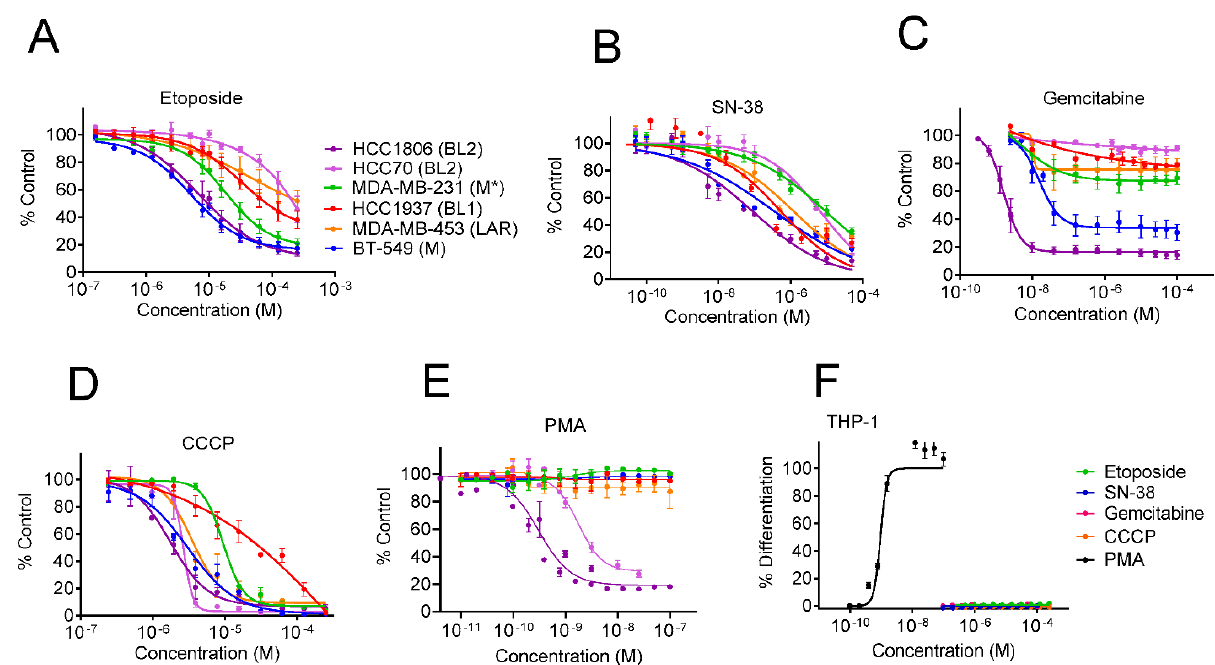
Figure 3. TNBC selectivity and THP-1 differentiation profiles of compounds with mechanisms associated with yuanhuacine. Concentration response curves of the growth of cell lines that represent diverse TNBC molecular subtypes when treated with the topoisomerase inhibitors ( A ) etoposide and ( B ) SN-38, ( C ) the DNA damaging agent gemcitabine, ( D ) the mitochondrial uncoupling agent CCCP, or ( E ) the PKC agonist PMA for 48 h. ( F ) Concentration response curve of THP-1 cell differentiation when treated with etoposide, SN-38, gemcitabine, CCCP, or PMA for 24 h. * The MDA-MB-231 cell line was originally classified as the MSL subtype and regrouped into the consolidated M subtype due to its mesenchymal phenotype. Error bars indicate the SEM of 2-4 biological replicates.